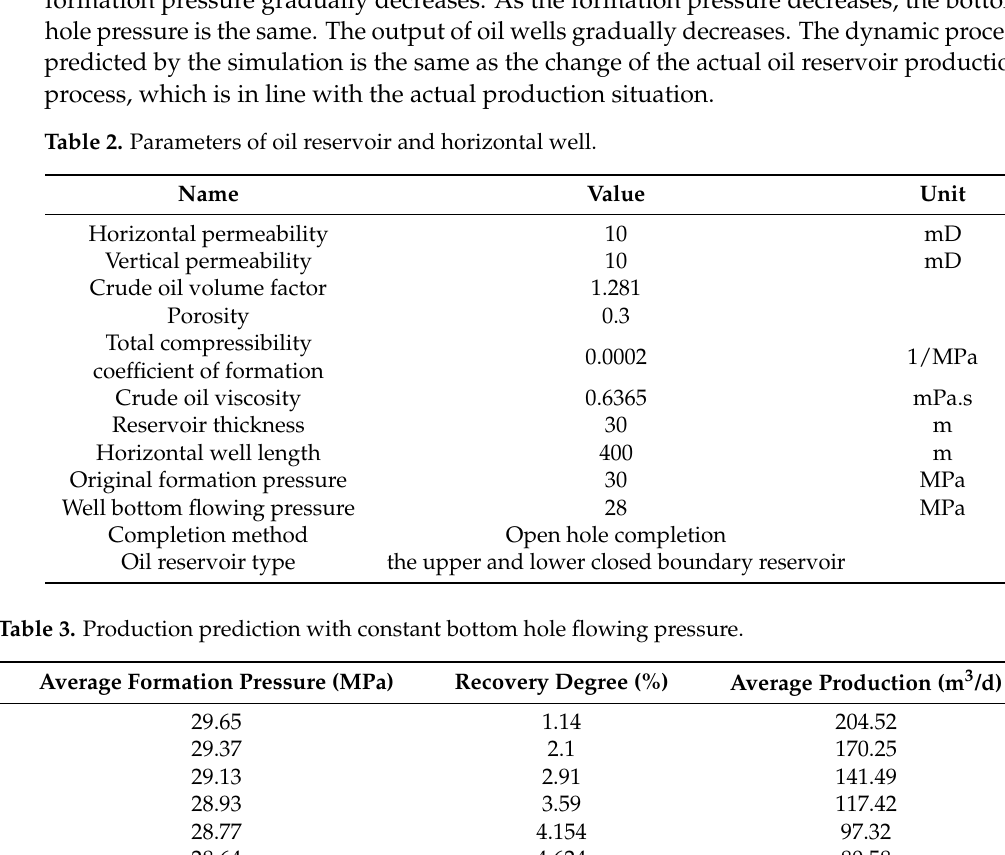
Table 2. Parameters of oil reservoir and horizontal well.